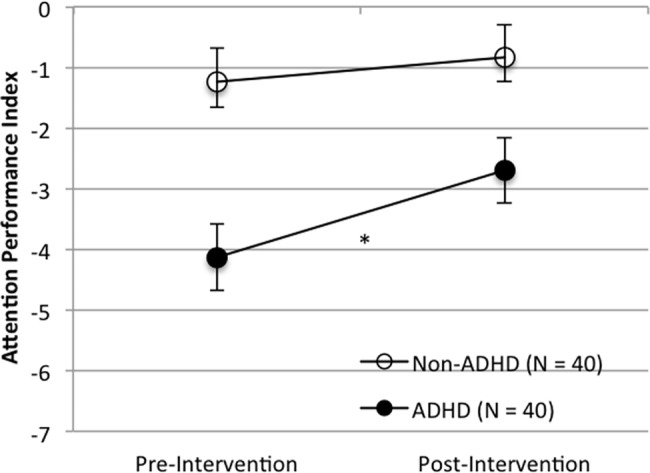
Performance on the TOVA API pre- and post-intervention for the ADHD group and the non-ADHD group.Note: Error bars represent standard error of the mean (*p < 0.05; ** p < 0.005).